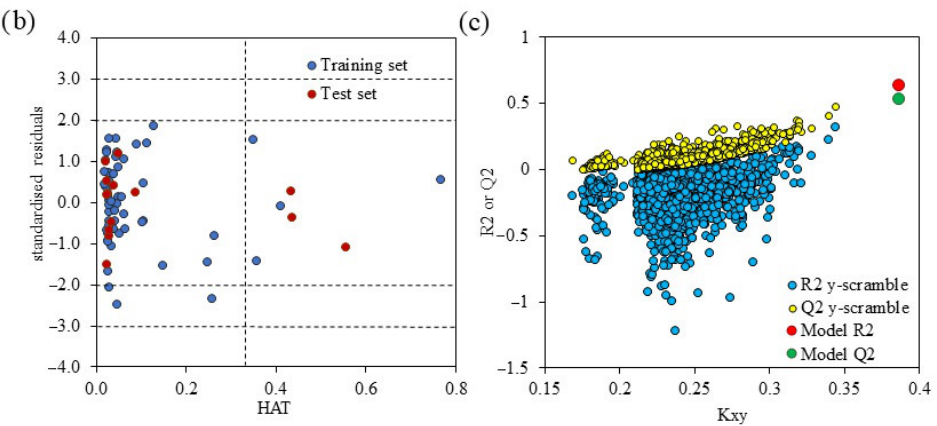
Figure 2. Plots representing ( a ) model linearity, ( b ) Williams plot and ( c ) validation using “Y-scrambling”.